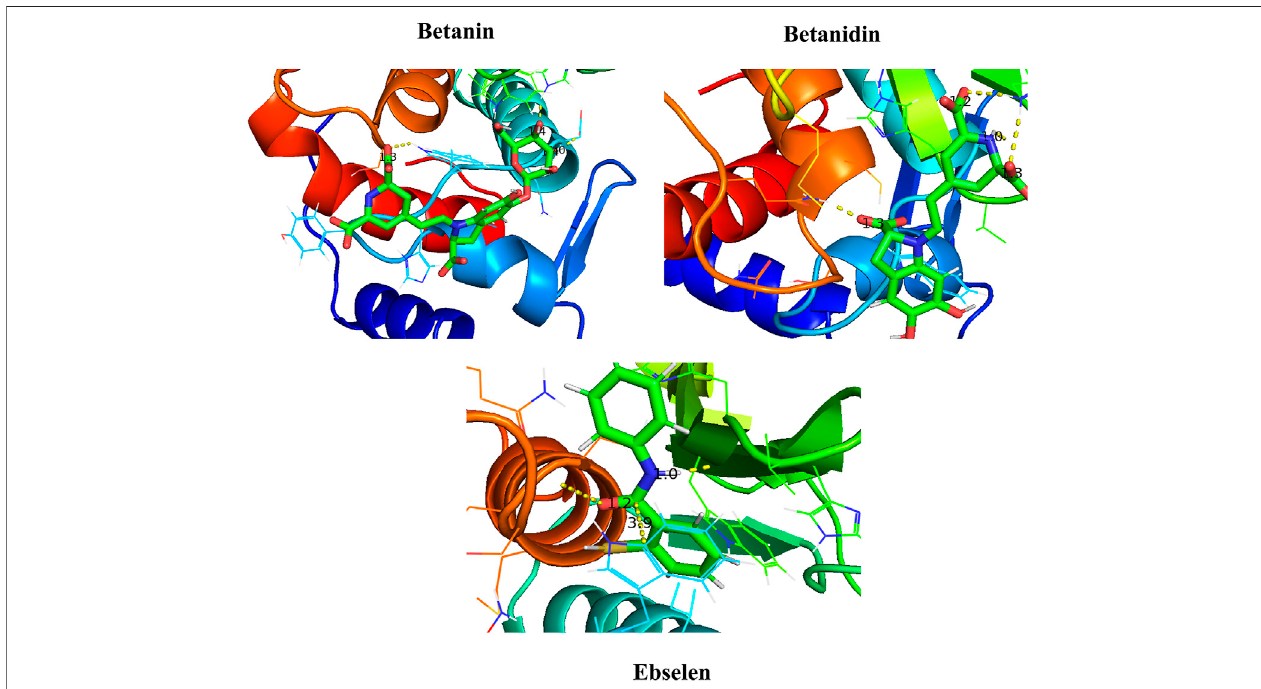
FIGURE 7 | Binding between Betanin, Betanidin, and Ebselen with SENP2 by PyMOL after molecular dynamics simulation (3D structures).